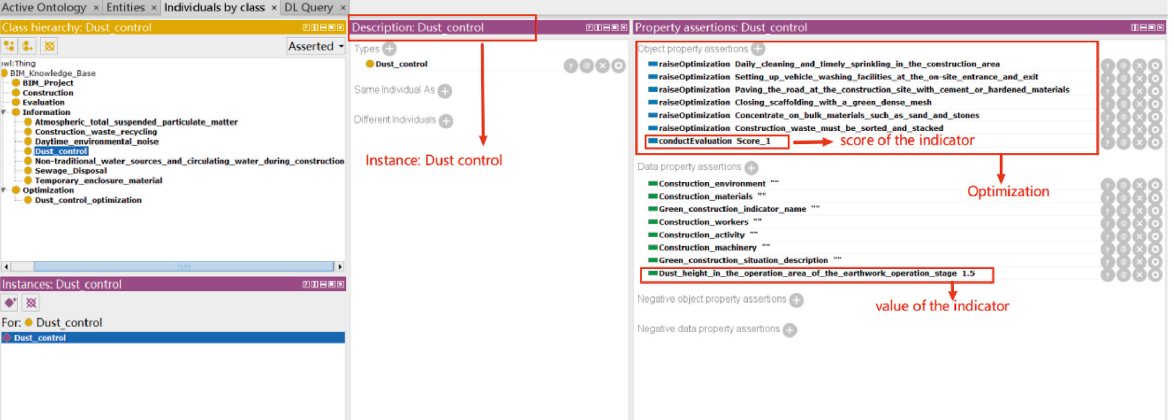
Figure 11: Induction instance of “dust control.”